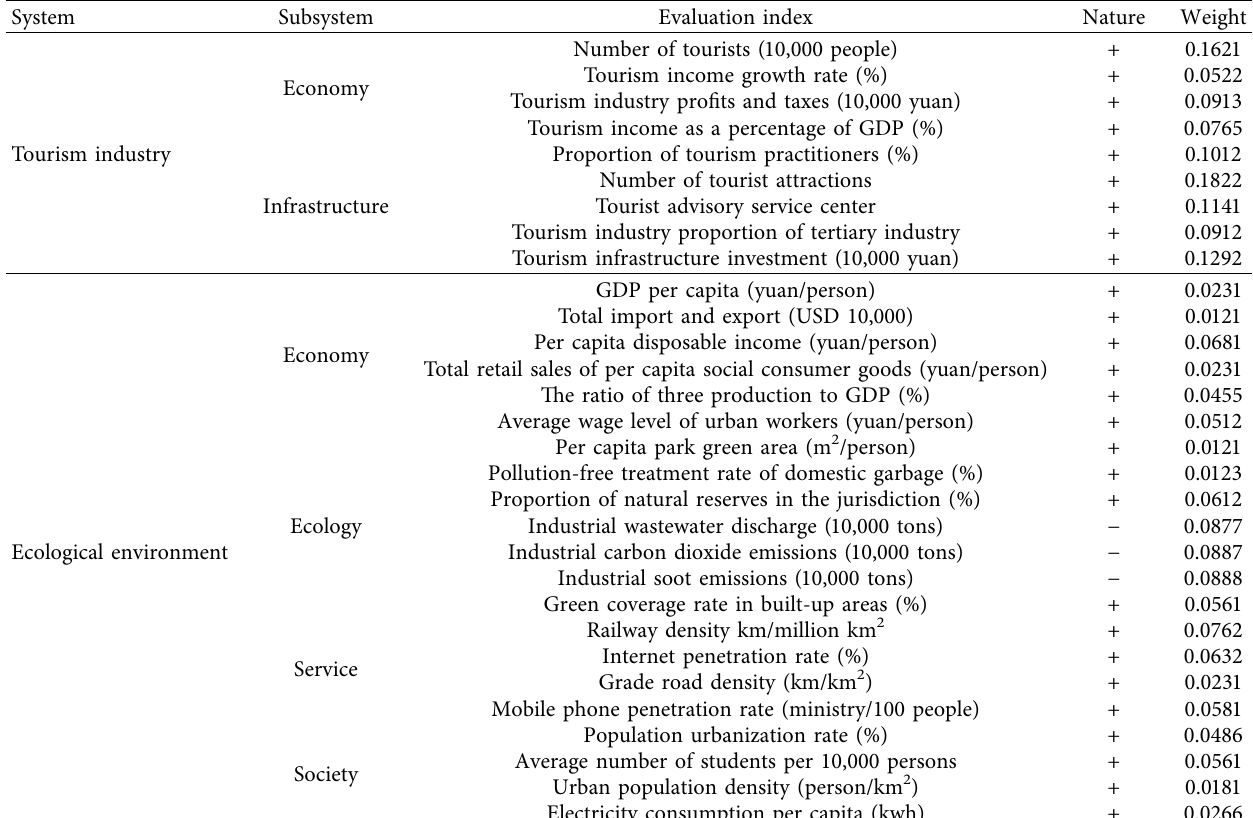
Table 3: Coupling evaluation index system of the tourism industry and the ecological environment.